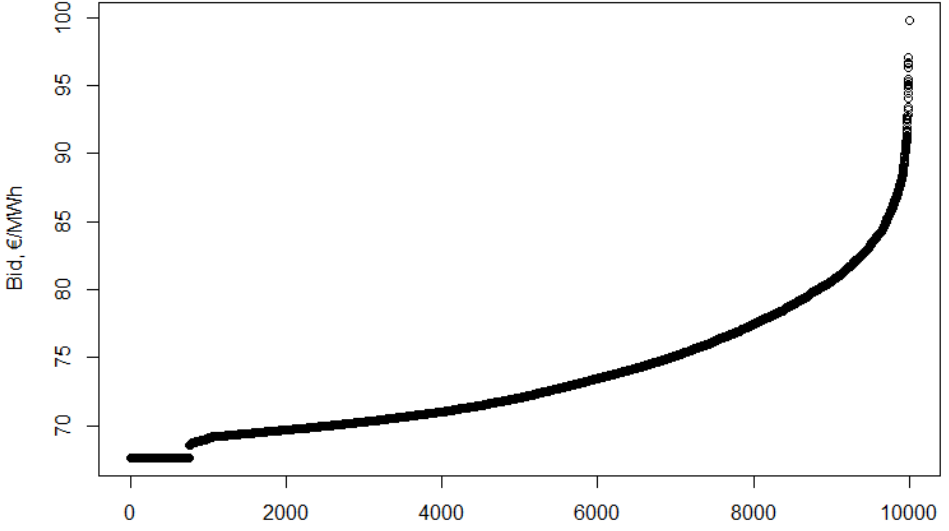
Figure A5. Sorted optimal bids, assuming F 2 bid distribution, source: own figure.